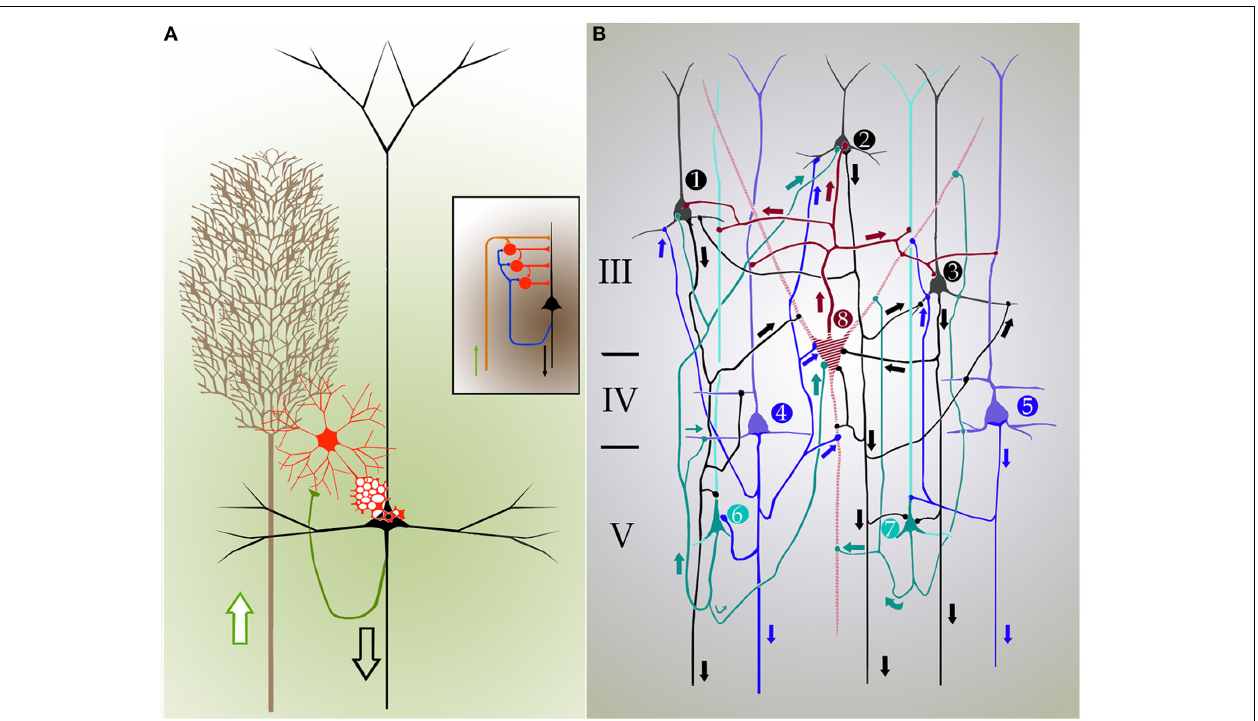
FIGURE 4 | Cartoons depicting the inner organization and synaptic interactions in the mammalian isocortex. Arrows designate directionality of nerve impulses. (A) Cylindrical unit composed of afferent fibers (brown), short-axon (red), and pyramidal cells. Axon impulses arrive via talamo-cortical fibers (brown), and target short-axon neurons (red), and pyramids (black) that send efferent axons. A set of collaterals from the pyramidal cell axon (green) ascend back to the interneuronal pool and adjacent homologs. Inset. Synaptic interactions between individual components of the cortical elemental unit that represent the structural basis for cortical reflexes. (B) Diagram showing a closed, self-exciting chain in the entorhinalis cortex. 1, 2, 3–pyramids